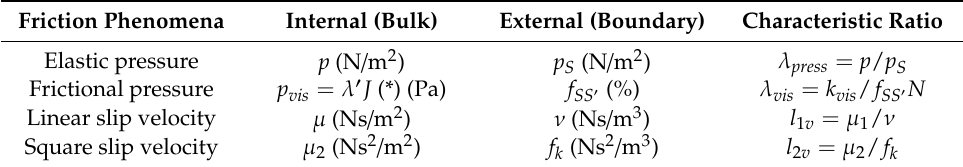
Table 1. Comparison of a concise model of internal and external friction according to Newton’s postulate. The model (*) of a viscous bulk pressure has been proposed by Natanson [31,57].